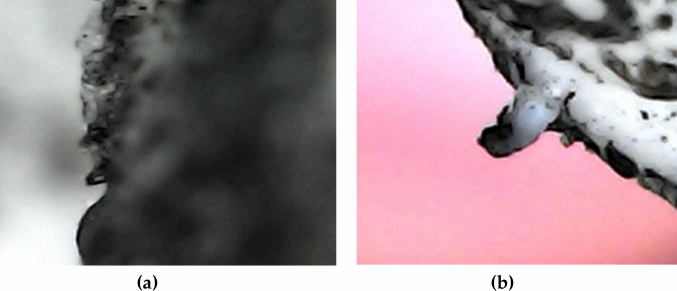
Figure 15. Microscopic morphology of OSW—liquid silica gel interface ( a ) pointed synapses; ( b ) Magnified morphology of pointed synapses.